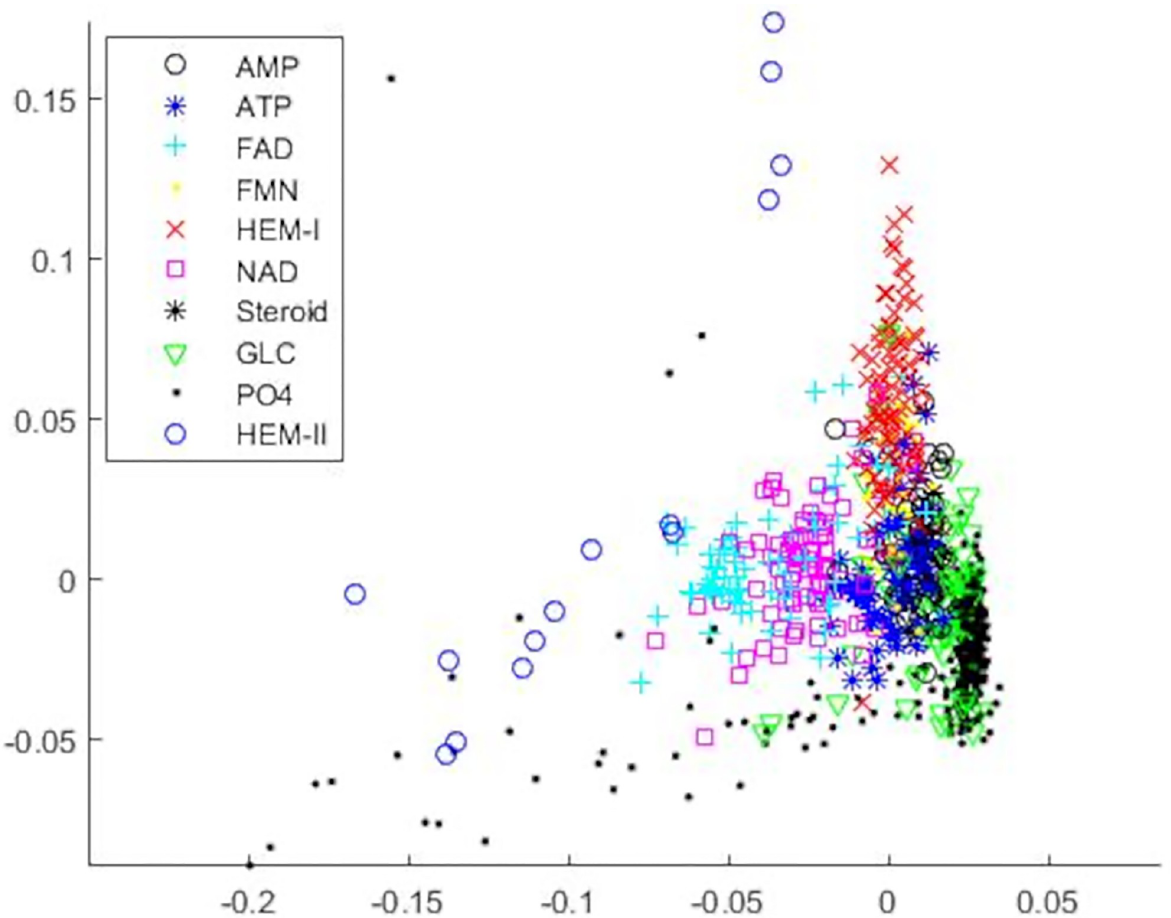
Fig 6. MDS plot in 2 dimensions of the entire cleaned extended Kahraman dataset. This multidimensional scaling plot visualizes the cleaned extended Kahraman dataset represented using CDPA in 3 dimensions. The binding sites are color-and-symbol coded according to the ligand they bind